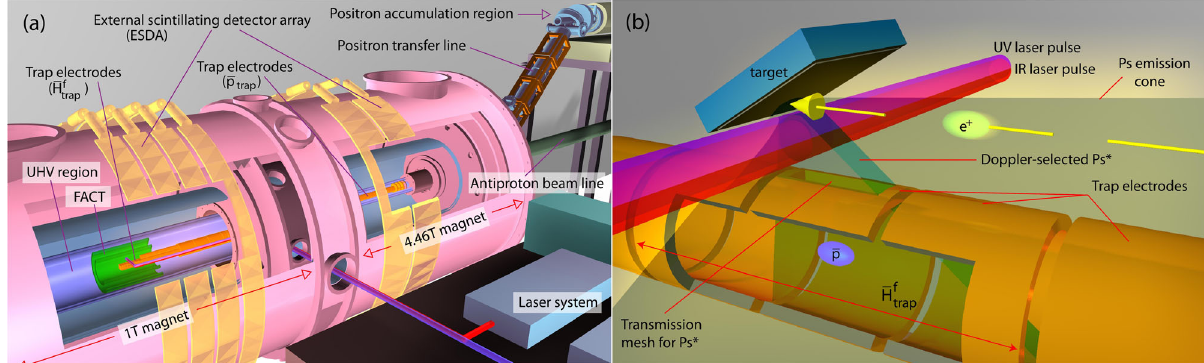
Fig. 1 Sketch of the AEgIS apparatus. a e + accumulation region on the top of the (cid:1) p beam line and the e + transfer line (made of 0.1 T pulsed magnets) coupled to the cryostat of the superconducting magnets containing the (cid:1) p trap and (cid:1) H f traps. The z -axis is the direction of the superconducting magnetic trap fi eld. Also shown are the fast cryogenic tracker (FACT) detector and the external scintillating detector array (ESDA) surrounding the cryostat. The whole trap structure is made of 101 electrodes of various lengths, mounted inside the cryostat of the magnet, at a temperature of 10 K. b Blow-up of the (cid:1) H production region. The (cid:1) H f trap is located 1.3 cm below the target acting as e + to Ps converter and it features a special design with semi-transparent trap electrodes on top to allow the passage of